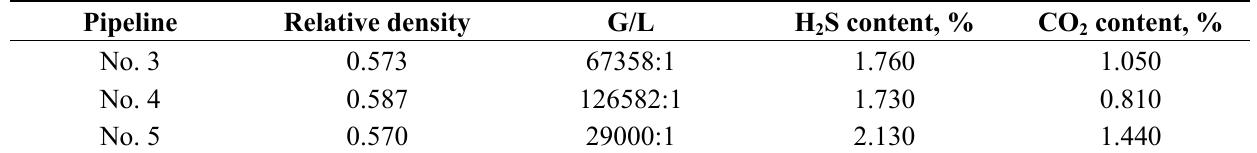
Table 5. The compositions of pipelines No. 3, No. 4, and No. 5.